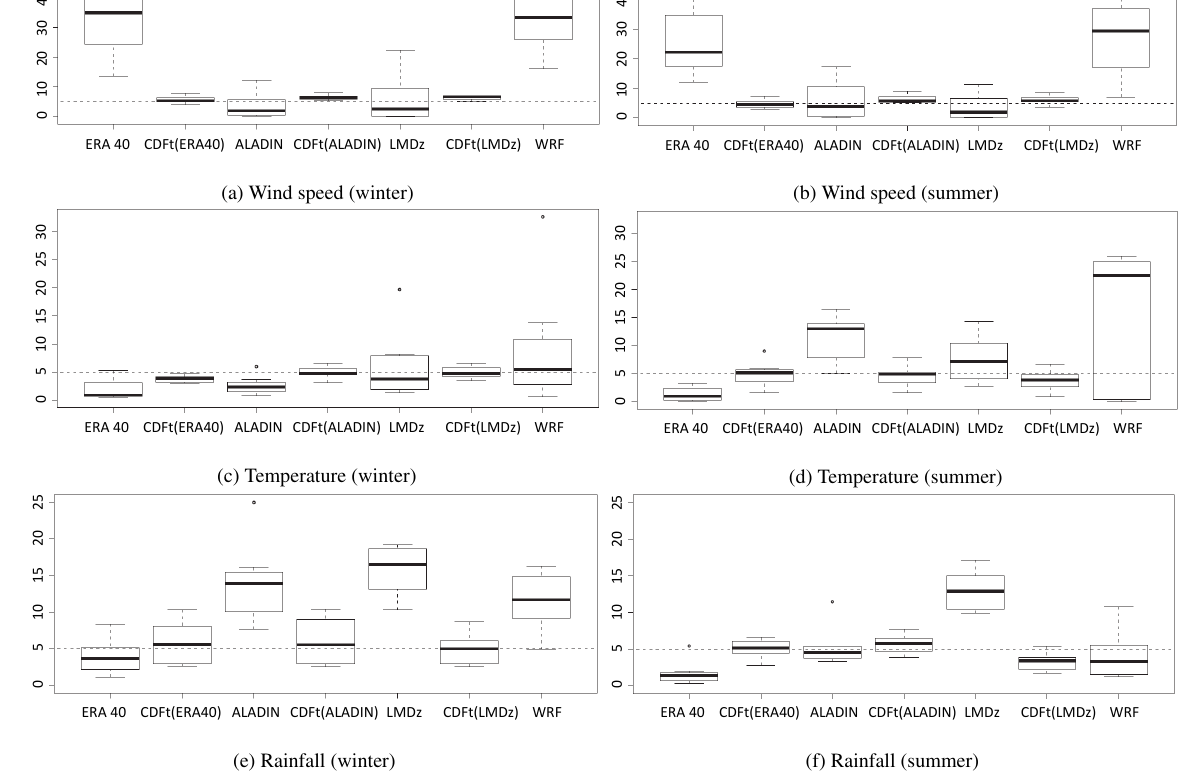
Fig. 5. Boxplots of percentage of values higher than the observed 95th percentile for the evaluation period (1996–2000 for wind, and 1991– Fig. 5: Boxplots of percentage of values higher than the observed 95 th percentile for the evaluation period (1996-2000 for Fig. 5: Boxplots of percentage of values higher than the observed 95 th percentile for the evaluation period (1996-2000 for 2000 for temperature and rain) in winter (left column) and summer (right column). The closer to the dashed line at 5%, the better the simulation of the Fig. 5: Boxplots of percentage of values higher than the observed 95 th percentile for the evaluation period (1996-2000 for Fig. 5: Boxplots of percentage of values higher than the observed 95 th percentile for the evaluation period (1996-2000 for wind, and 1991-2000 for temperature and rain) in winter (left column) and summer (right column). The closer to the dashed wind, and 1991-2000 for temperature and rain) in winter (left column) and summer (right column). The closer to the dashed Fig. 5: Boxplots of percentage of values higher than the observed 95 th percentile for the evaluation period (1996-2000 for Fig. 5: Boxplots of percentage of values higher than the observed 95 th percentile for the evaluation period (1996-2000 for wind, and 1991-2000 for temperature and rain) in winter (left column) and summer (right column). The closer to the dashed wind, and 1991-2000 for temperature and rain) in winter (left column) and summer (right column). The closer to the dashed line at 5%, the better the simulation of the extremes. line at 5%, the better the simulation of the extremes. wind, and 1991-2000 for temperature and rain) in winter (left column) and summer (right column). The closer to the dashed wind, and 1991-2000 for temperature and rain) in winter (left column) and summer (right column). The closer to the dashed line at 5%, the better the simulation of the extremes. line at 5%, the better the simulation of the extremes. line at 5%, the better the simulation of the extremes. line at 5%, the better the simulation of the extremes.